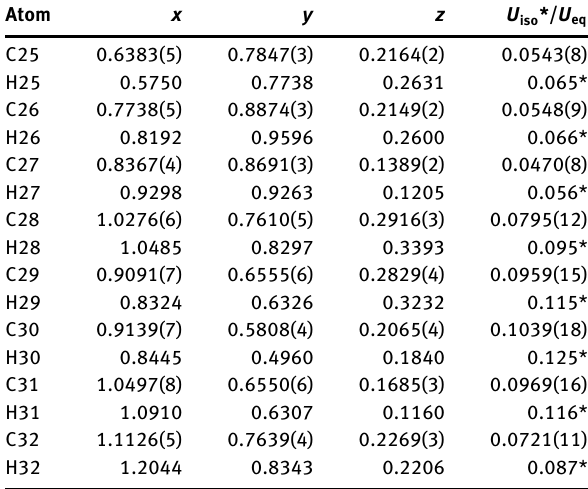
Table 2: Fractional atomic coordinates and isotropic or equivalent isotropic displacement parameters (Å 2